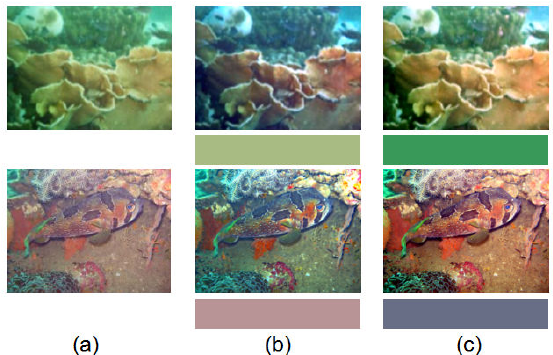
Figure 13. Comparisons on the estimated ambient light and restoration results. Each ambient light is visualized as a colored bar for the convenience of comparison. ( a ) underwater images; ( b ) the results of Shin et al. [29]; ( c ) the results of the proposed